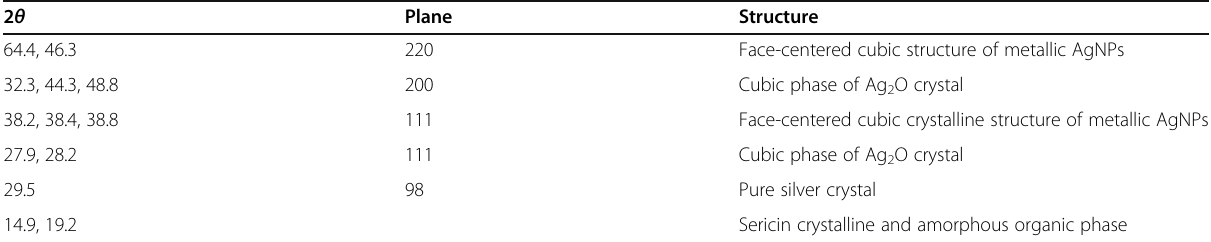
Table 2 X-ray diffraction scattering data for various crystalline structures 2 θ Plane